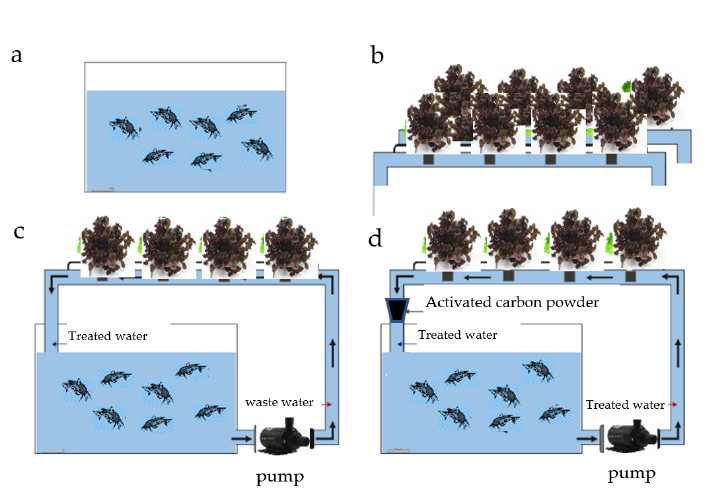
Figure 1. ( a ) aquaculture system; ( b ) hydroponic system; ( c ) aquaponics system; and ( d ) aquaponics system with activated carbon